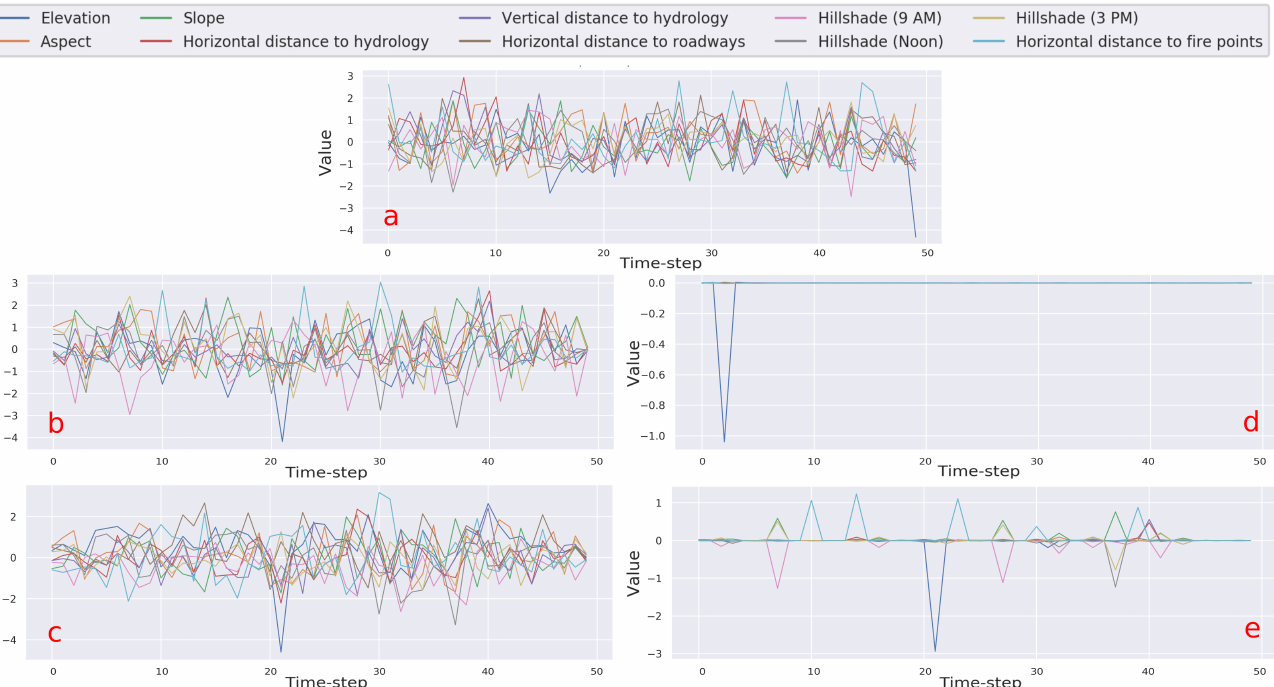
Figure 2. Comparison of different auto-encoder outputs ( a ) original input, ( b ) reconstruction from the vanilla auto-encoder, ( c ) Palacio et al. [11], ( d ) auto-encoder fine-tuned with sparsity and ( e )